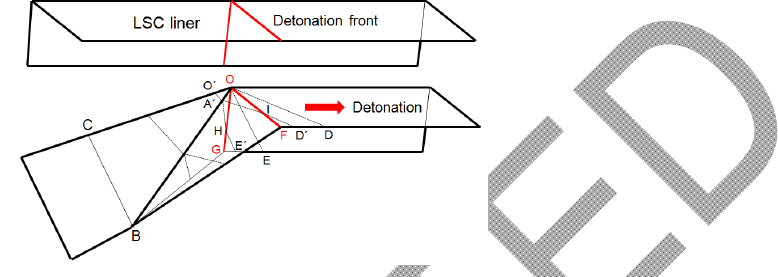
Figure 1. Schematic diagram of LSC liner movement during detonation.